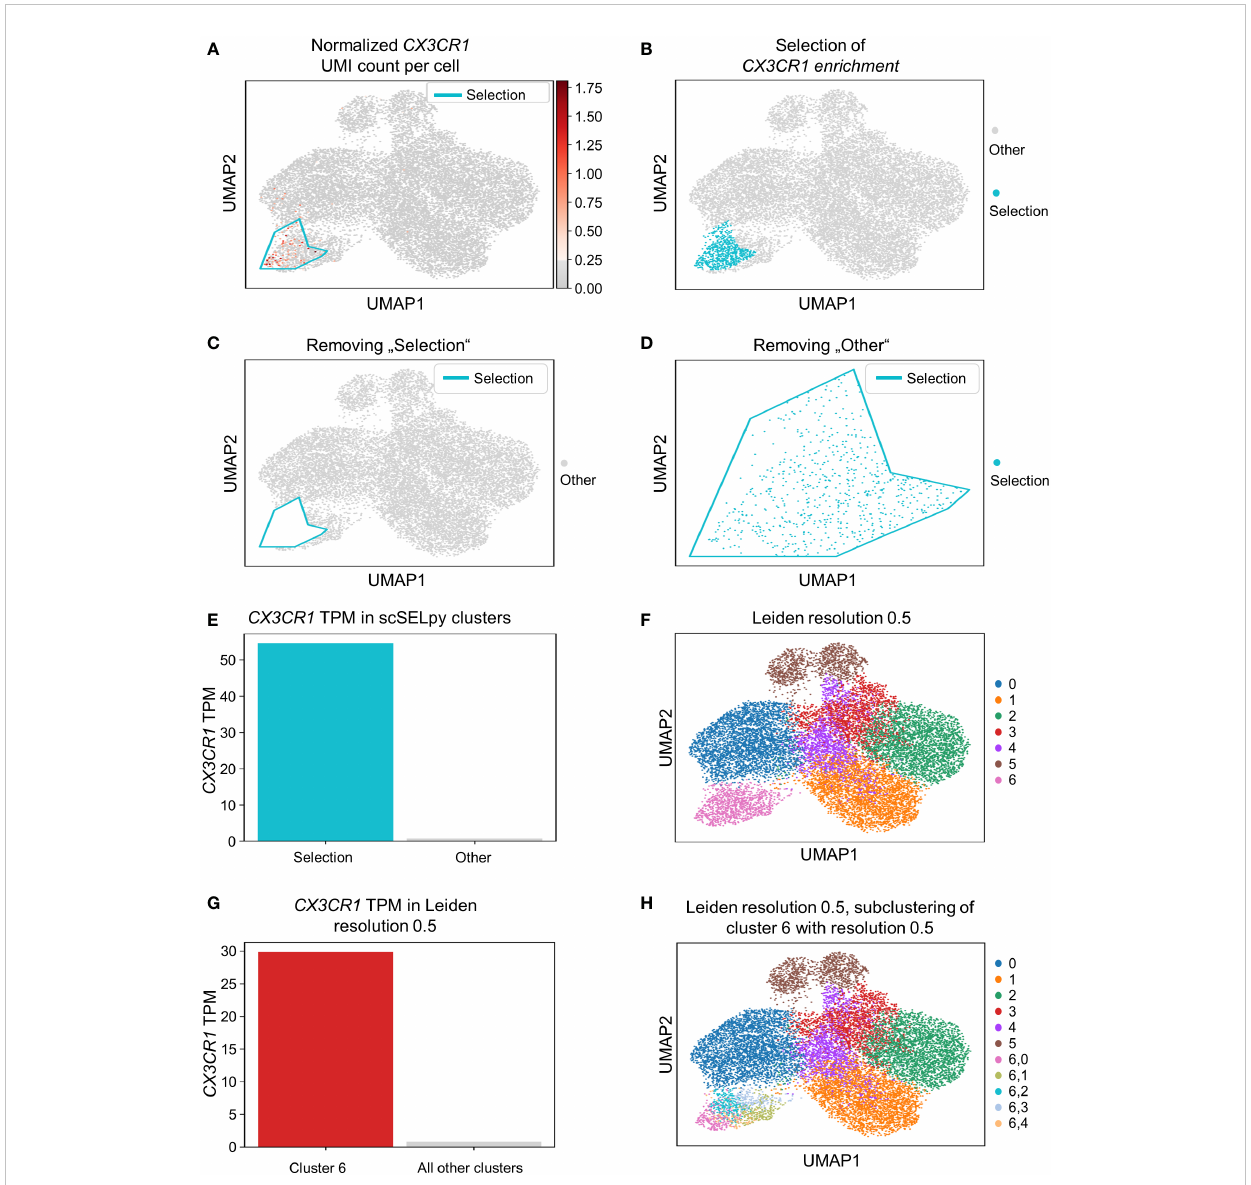
FIGURE 1 Positive selection of cell subsets on a Scanpy-generated UMAP plot with the scSELpy tool. (A) UMAP expression plot of CX3CR1 . Regions with high CX3CR1 expression were manually selected using scSELpy. (B – D) The cells located in the selected region can be highlighted (B) , removed (C) , or isolated (D) in downstream analysis. (E) Barplot with CX3CR1 transcripts per million transcripts (TPM) for the selected cells versus all other cells. (F) Leiden clustering of the dataset with a resolution of 0.5. (G) Barplot with CX3CR1 TPM for cluster 6 and all the other clusters together. (H) Subclustering of the leiden cluster 6 from (E)